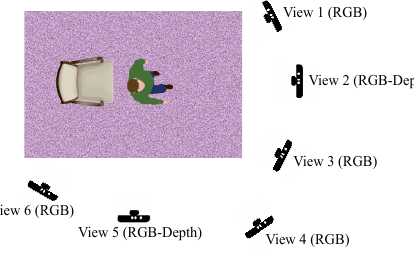
Figure 2. Typical camera views in the QMAR dataset with each one placed at a different